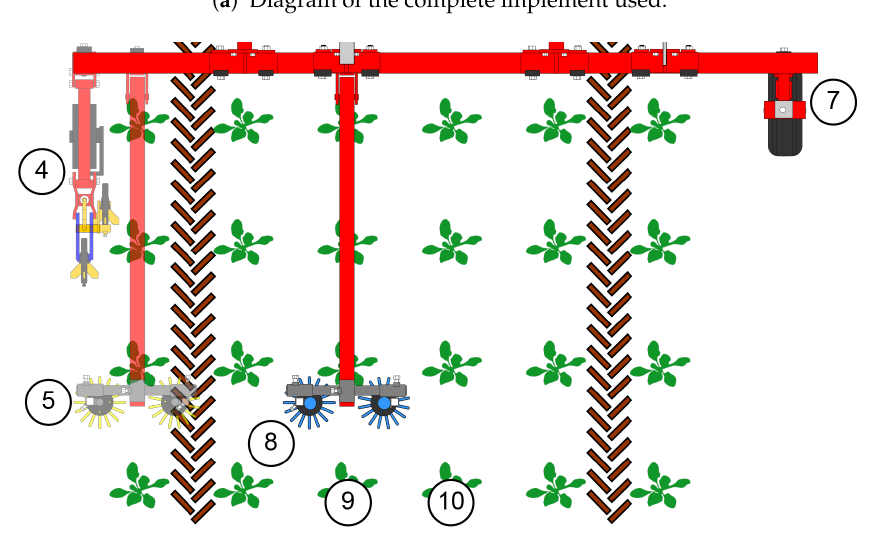
Figure 1. The set-up of the hoe used in the experiments at Ihinger Hof in 2017 and 2018. The image displays one plot width (six sugar beet rows). 1 = Garford Robocrop, 2 = Garford Robocrop camera for inter-row weeding, 3 = Argus hoe frame, 4 = parallelograms with goosefoot sweeps, 5 = conventional finger weeders, 6 = bi-spectral camera for intrarow weeding (colour blue), 7 = odometry wheel, 8 = motorized finger weeders (colour blue), 9 and 10 = the two center sugar beet rows of each plot that were treated with the MFW and used for harvesting. Design elements by K.U.L.T.